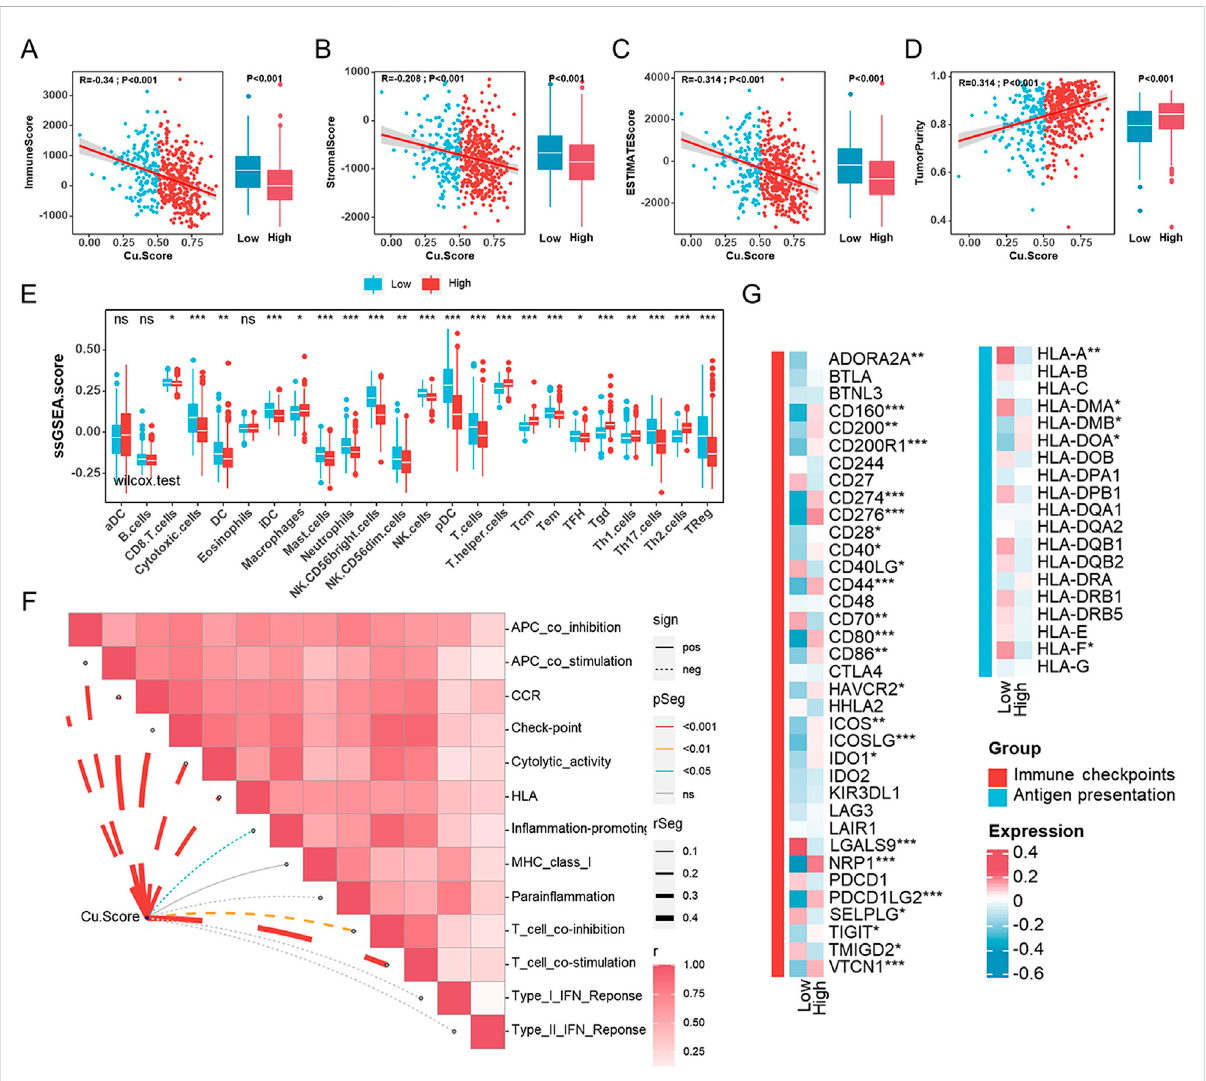
FIGURE 5 Characteristics of the tumor microenvironment in different Cu. Score subgroups (A – D) . The correlation analyses between Cu. Score with ImmuneScore (A) , StromalScore (B) , ESTIMATEScore (C) , and TumorPurity (D) . (E) Comparisons of the abundances of 24 immune cells in two subgroups. (F) . The relationships between Cu. Score and immune-related function scores. (G) The heatmap of the comparison of the immune checkpoints and HLA genes between the high- and low-Cu. Score